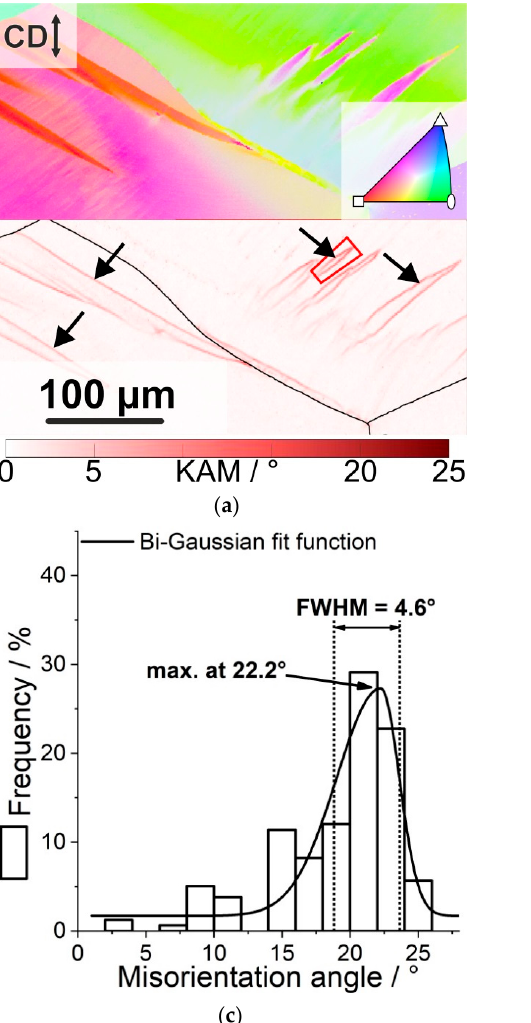
Figure 4. Microstructural analysis of compression deformed HfNbTaTiZr ( 𝑇 = 298 K, 𝜀 (cid:3043)(cid:3039),(cid:3046)(cid:3047)(cid:3042)(cid:3043) = 9.8%): ( a ) Color-coded orientation map on a longitudinal section shows grains of the bcc solid solution phase; compression direction (CD) is vertical, and the color code corresponds to the inverse pole figure (IPF) in the inset. Black arrows highlight kink bands. Microstructural details within the red rectangle are analyzed in an enlarged view in Figure 5. ( b ) Color-coded orienta- tion distribution of the CD in an IPF determined from the orientations as shown in the map of ( a ).